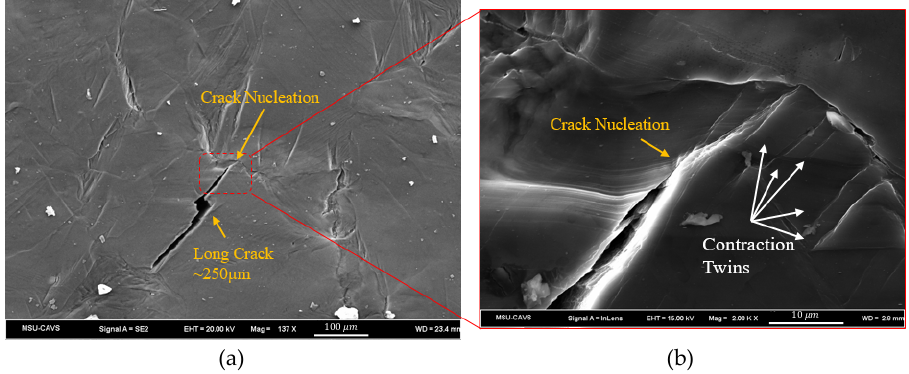
Figure 10. ( a ) Micrograph of evident contraction twins near long crack nucleation and ( b ) enlarged micrograph showing sharp surface steps made by these contraction twins.